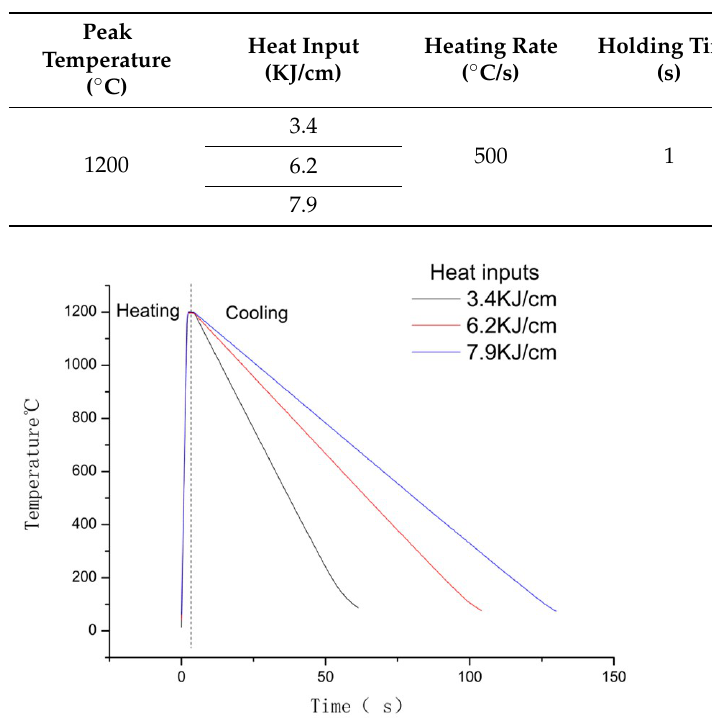
Table 2. The simulation parameters.